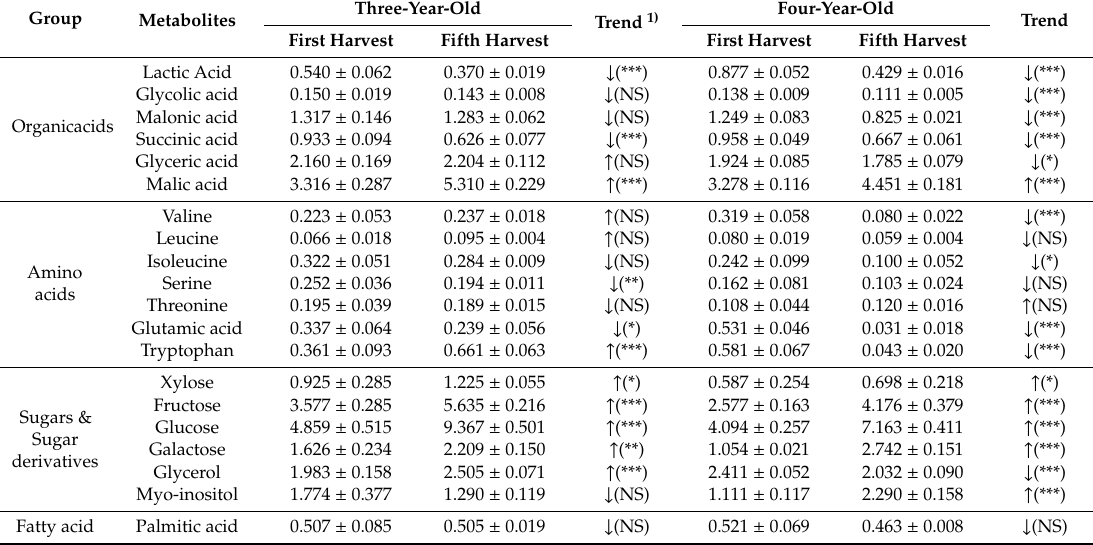
Table 1. Changes of identified metabolites with di ff erent ripening stages in three-year-old GB and four-year-old